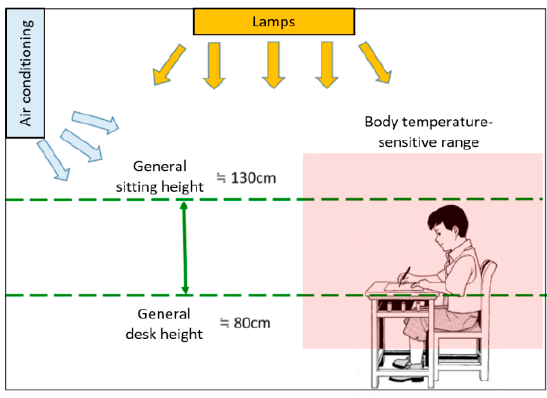
Figure 3. Layout of experimental research environment.